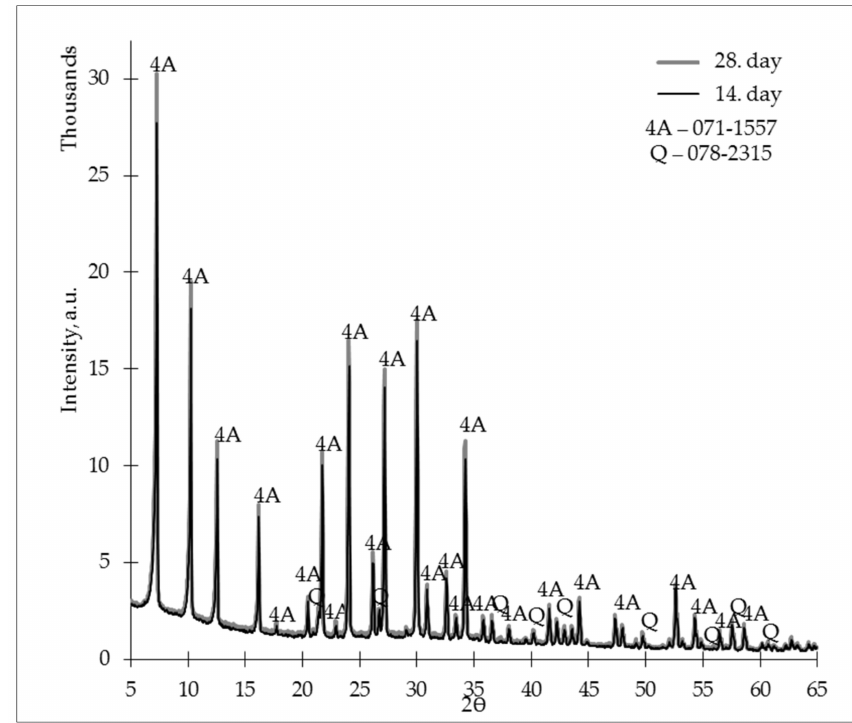
process, which means that zeolite granules made with an L/S ratio of 1.2 could develop a more intensive zeolite 4A crystalline phase in a shorter period.